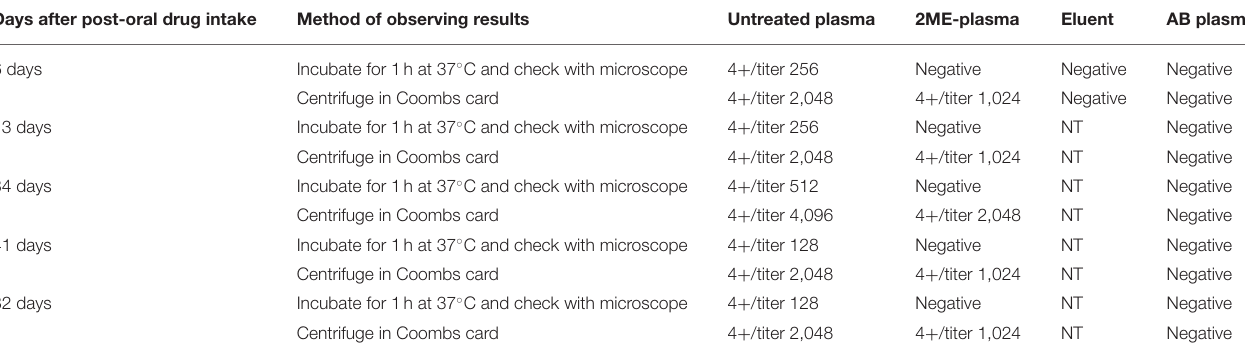
TABLE 2 | Test results of cimetidine-dependent antibody with RBCs and 1 mg/mL cimetidine solution (agglutination and titer). Days after post-oral drug intake